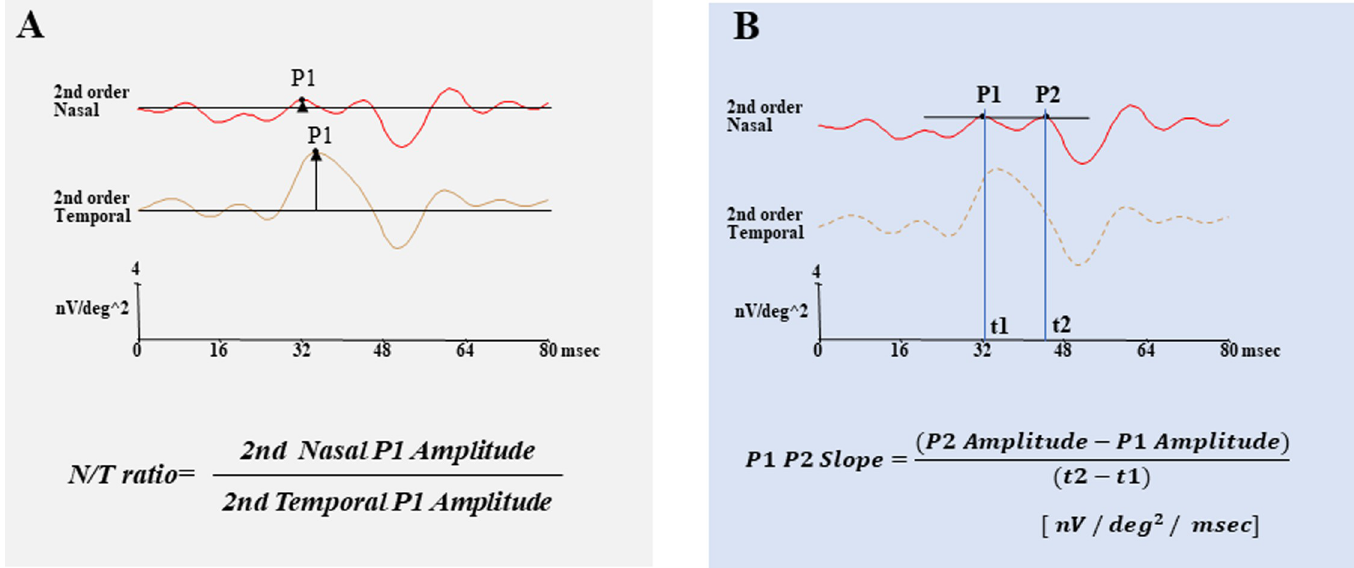
Fig 2. Ratio of the P1 amplitudes of the mfERGs of the nasal to the temporal hemisphere (N/T amplitude ratio) within the central 7.5˚ radius. A: Ratio is used to evaluate the asymmetry between the nasal and temporal fields. B: Slope of the line between P1 and P2 (P1P2 Slope) of the second-order kernel in the nasal field was used to evaluate the degree of